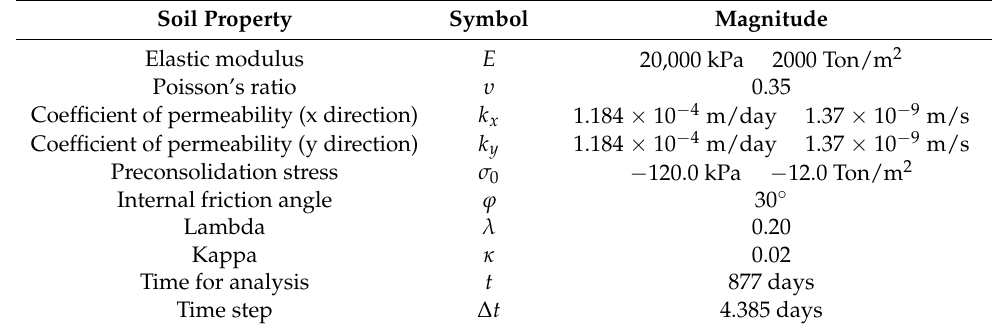
Figure 8. Pore pressure distribution and evolution at ( a ) 4.385, ( b ) 434.115, and ( c ) 872.615 days.